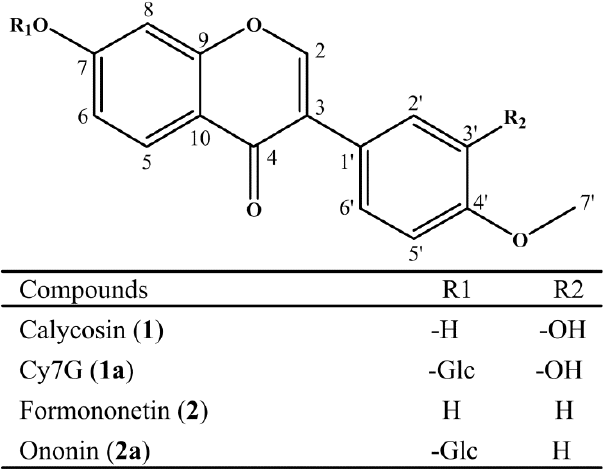
Figure 1. Chemical structures of calycosin, formononetin, and glucosylated products synthesized by UGT88E18.